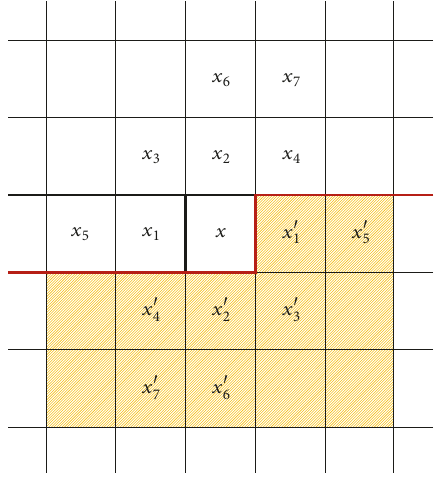
Figure 2: Context of the predicted pixel 𝑥